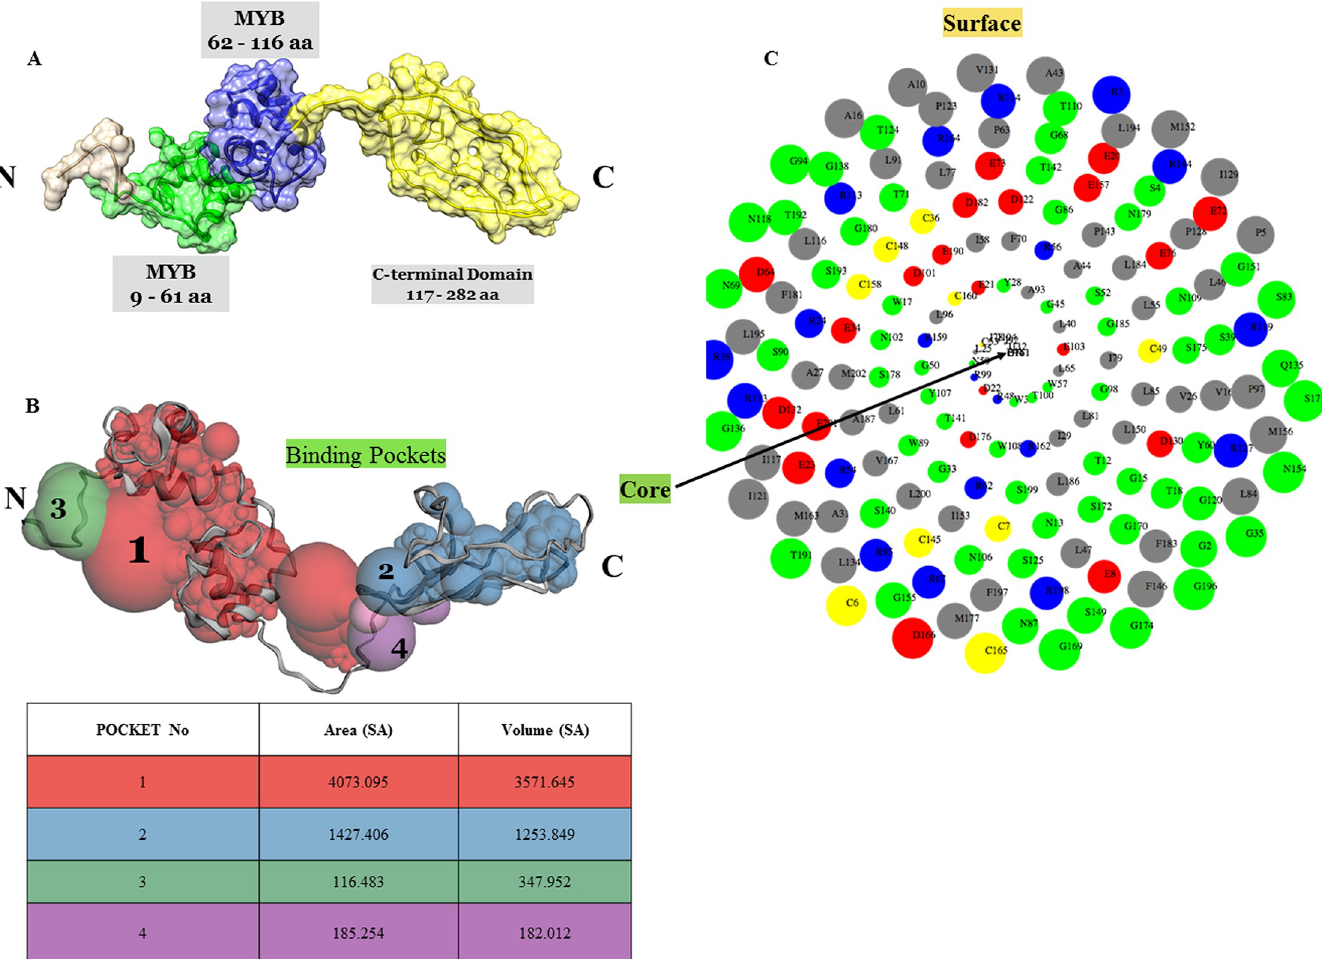
Fig 2. Structural model of AtMYB4. A. The N-terminal first and second MYB domains are labeled and shown in green and blue colour, respectively. The C-terminal transcriptional activation domain has been shown in yellow colour. B and C. The binding pockets and the surface properties are shown with the area and volume of the four surface pockets. Accessible surface area of AtMYB4 has been represented as Spiral Plot with the buried residues are located at the core while exposed residues are at the surface. Colour Code used: Blue: Positively charged residues (R, K, H), Red: Negatively charged residues (D, E), Green: Polar uncharged residues (G, N, Y, Q, S, T, W), Yellow: Cystein, Gray: Hydrophobic residues (All